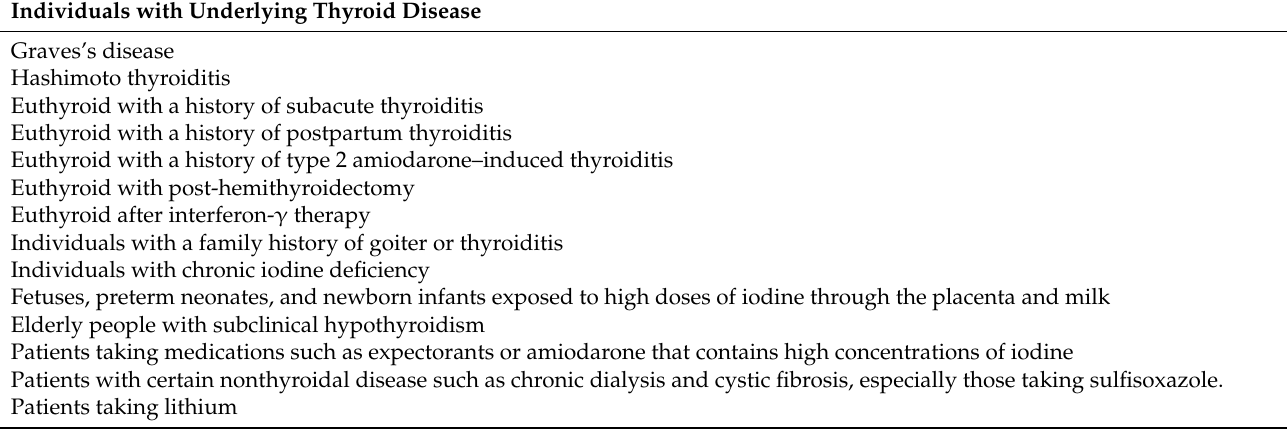
Table 1. Predisposing Risk Factors Associated with permanent Iodine-Induced Thyroid